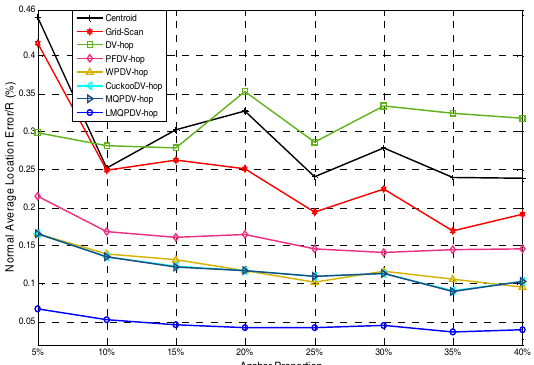
Figure 14. Communication range 250 WSN#2.